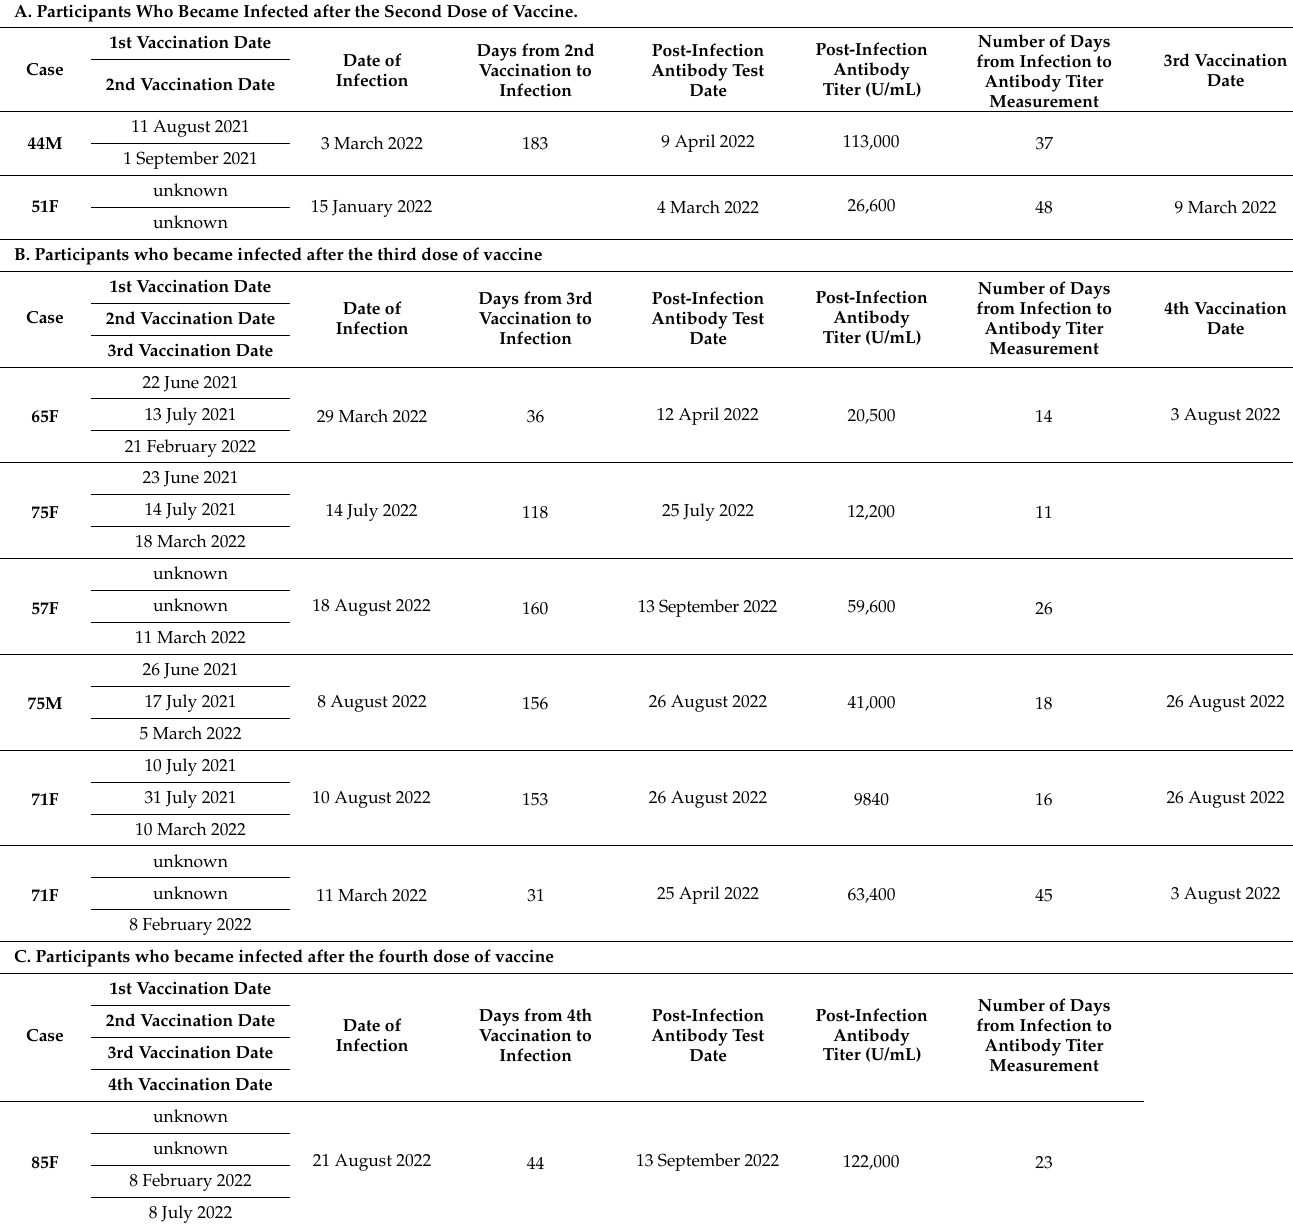
Table 3. Participants who became infected after the second (A), third (B), and fourth (C) dose of